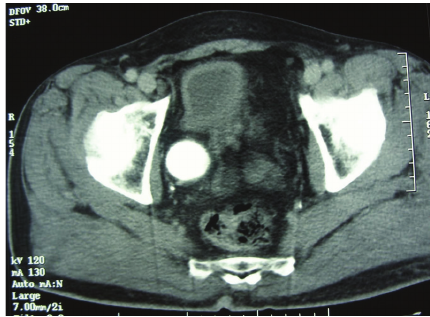
Figure 2: CT of the same patient showing pelvic ureteral stone.